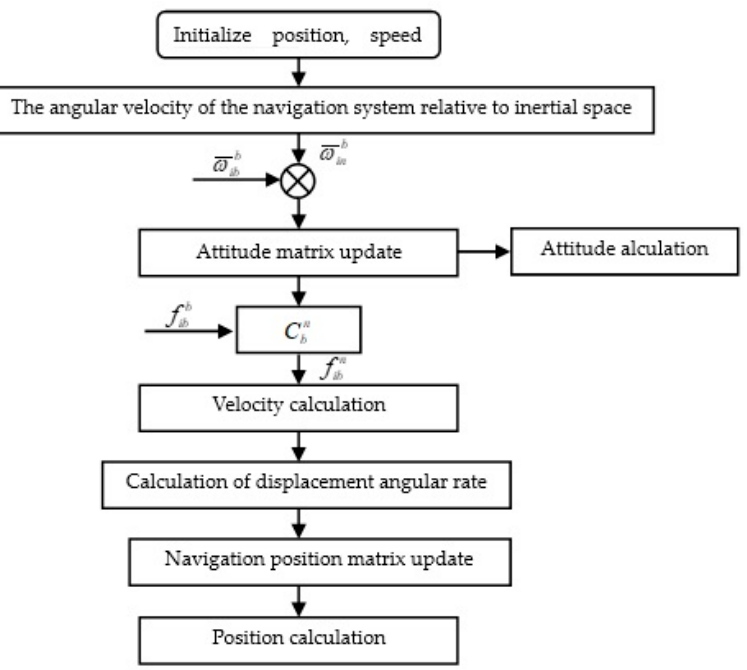
Figure 3. Strapdown solution flow of the inertial navigation system.